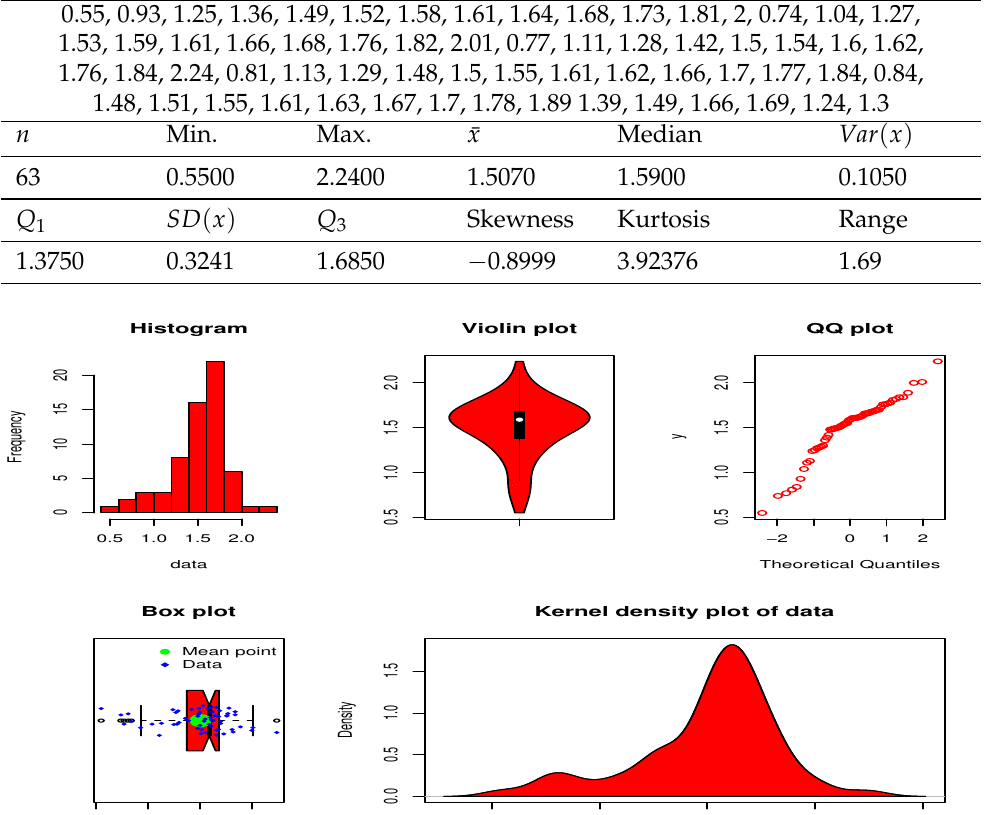
Table 10. The glass fibers data set with summary values.